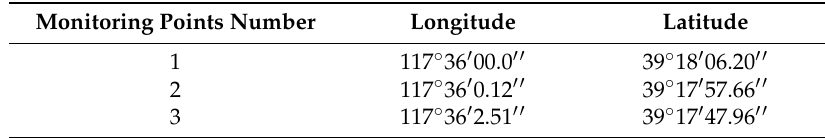
Table 1. Sampling sites layout information of Qilihai Wetland Core